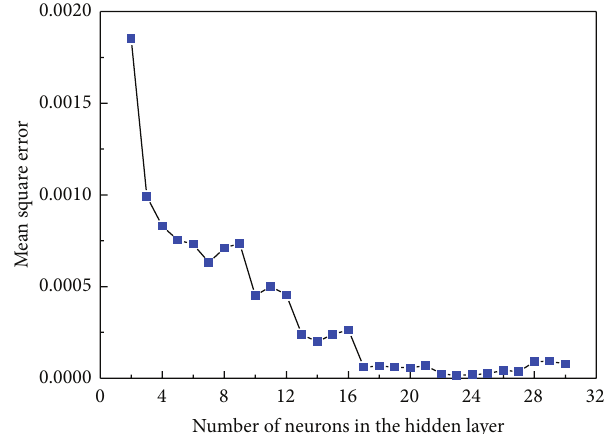
Figure 5: Influence of hidden neutrons on the network perfor-